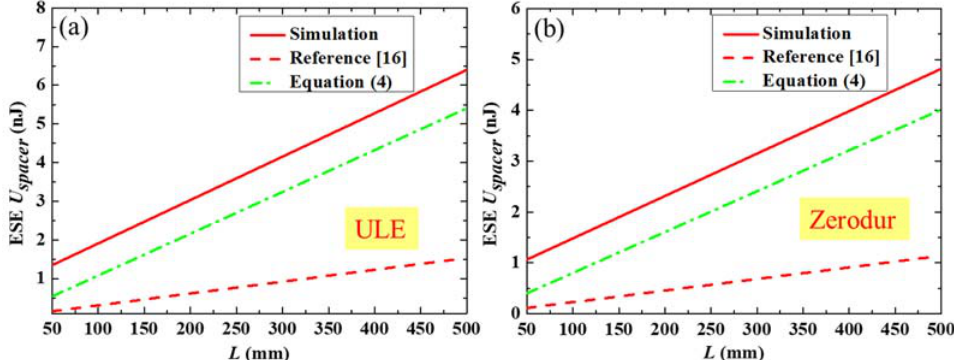
Figure 4. ESE as a function of the length L of the spacer made of room ‐ temperature materials. The solid red line represents the simulation results. The red dashed line denotes the analysis estimates based on Equation (2) in ref. [16]. The green dash ‐ dot line denotes the analysis estimates based on Equation (4). ( a ) All ‐ ULE USC. ( b ) All ‐ zerodur USC.